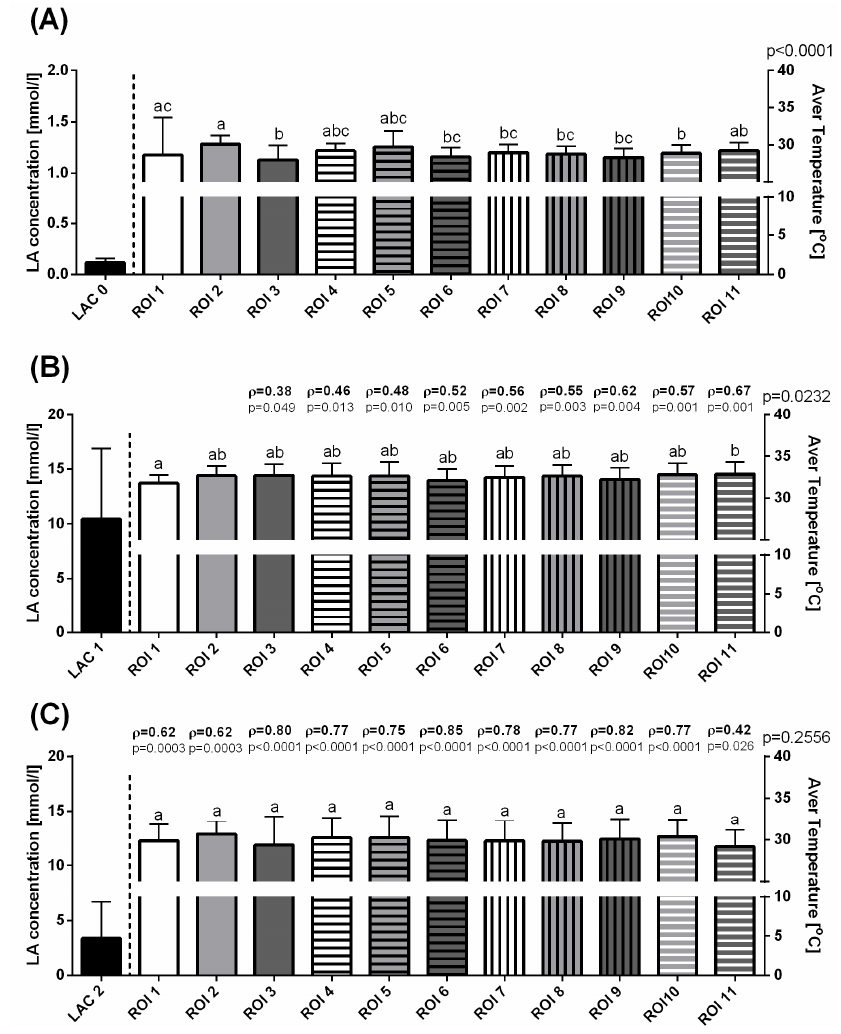
Figure 5. The blood lactate concentration and average temperatures (mean + SD) in the selected ROIs before training ( A ), immediately after exercise ( B ), and 30 min after exercise ( C ). Lowercase letters indicate di ff erences between regions of interest (ROIs) for p < 0.05. The p -value for ROI comparison is indicated above the right X -axis. The correlations between blood lactate concentration and average temperatures are indicated above consecutive temperature bars using the Spearman correlation coe ffi cient ( ρ ), which reflected the consistency when p < 0.05.